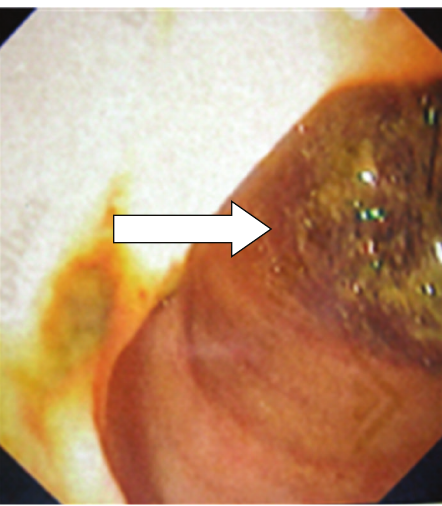
Figure 9: The proximal side of a large gallstone impacted in the 2nd to 3rd part of the duodenum (arrow).